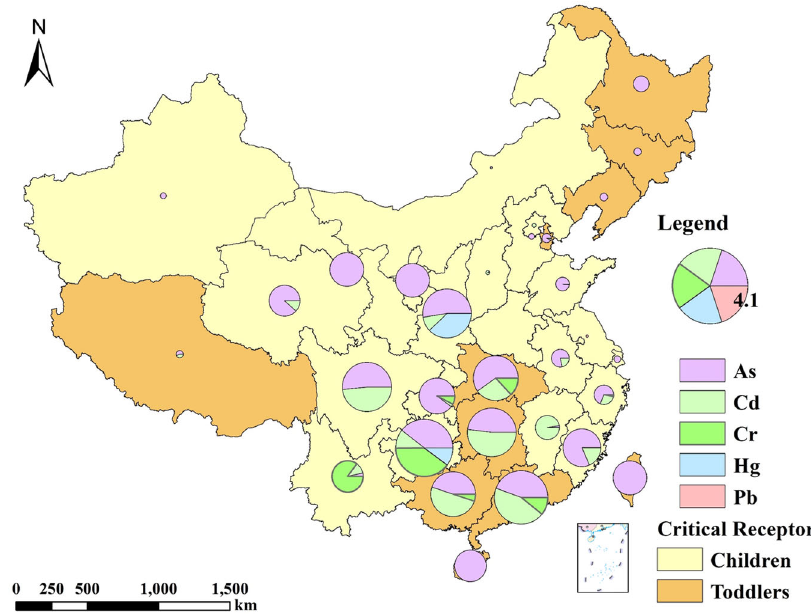
Fig. 3 Probability distribution of ultimate health risks and the contributions of Cd, As, Hg, Pb, and Cr to human health risks. [Note: The pie chart showed the contribution of fi ve heavy metals(loid) to the health risk. The large (small) sector area indicates the high (low) risk contribution. A complete pie chart indicated a contribution of 100%. The size of the pie chart represented the sum of the probability of fi ve heavy metal(loid)s exceeding the standard. The following abbreviations are used: Arsenic (As; purple), Cadmium (Cd; aqua), Chromium (Cr; green), Mercury (Hg; sky blue), Lead (Pb,